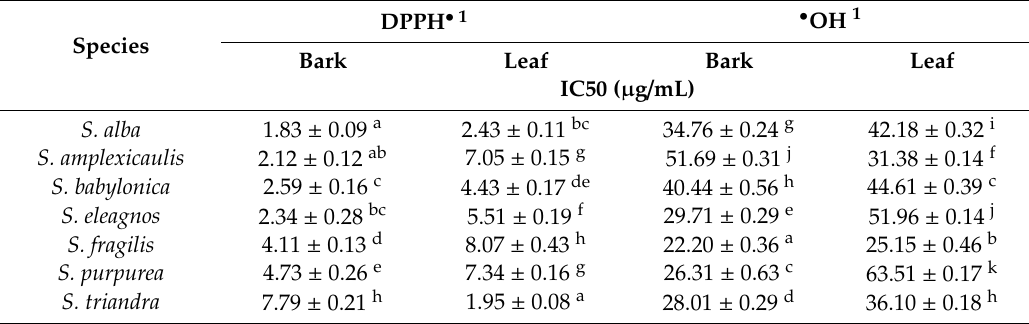
Table 4. DPPH and OH radical scavenging activity of bark and leaves extracts of species from the genus Salix